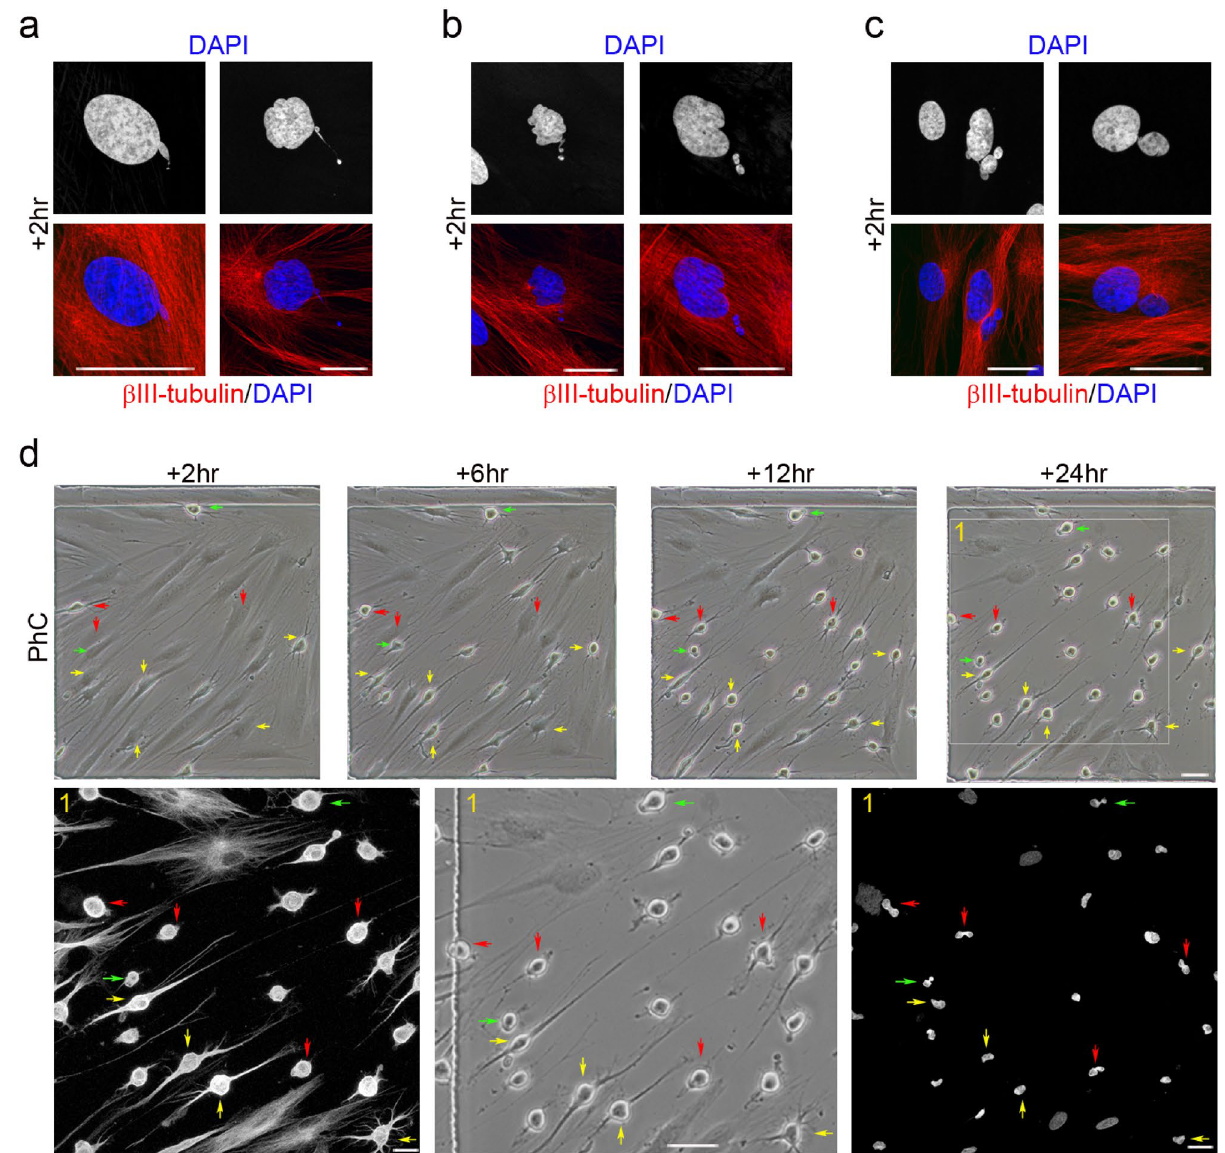
Figure 7. Nuclear shape remodelling occurs during neurogenesis from hBMSCs. DNA-containing structures arose from the main nuclei ( a ) and started to move ( b ) towards specific positions within the cell and temporarily formed lobed nuclei ( c ). These lobed nuclei then connected together through small DNA-containing structures to form nucleoplasmic bridges ( d , red arrows). Finally, the lobed nuclei connected by internuclear bridges ( d , green arrows) joined to form single nuclei with an eccentric position within hPDLSC-derived neuron-like cells ( d , yellow arrows). The scale bars are 50 μm in the phase-contrast photomicrographs, and 25 μm for confocal micrographs. PhC: Phase-contrast